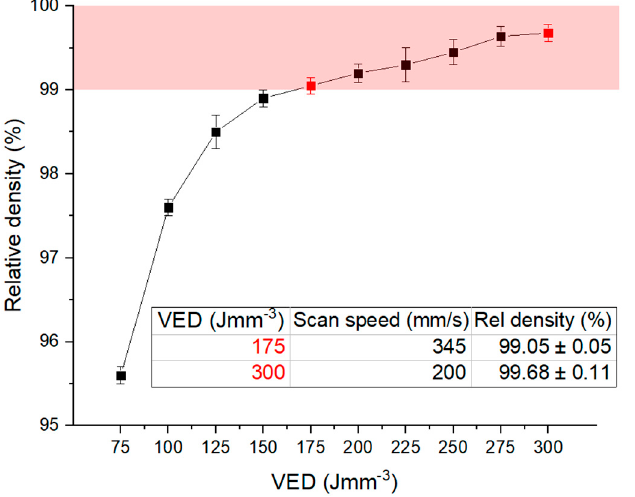
Figure 2. Relative density as a function of volumetric energy density. The optimal relative density zone (over 99%) is highlighted in red, and the two chosen VED conditions are marked and described in the table.